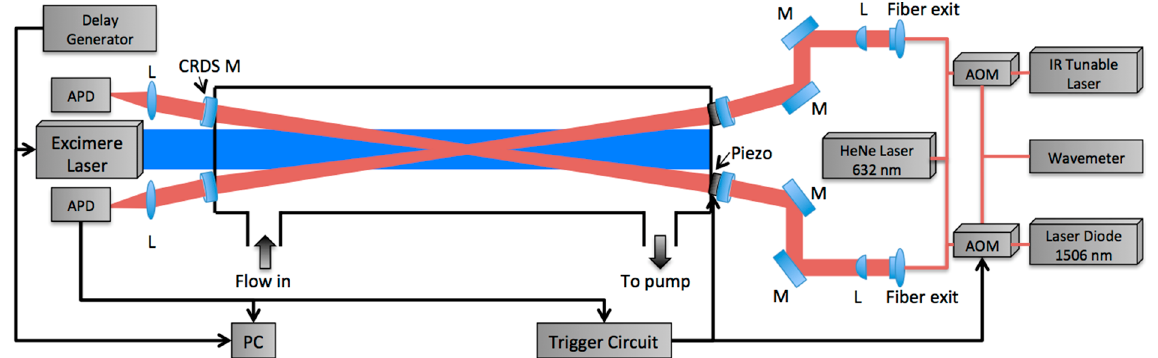
Figure 1. Schematic view of the used experimental setup: AOM, Acousto-Optic Modulator; APD, Avalanche Photo Diode; M, Mirror; L, Lens. Both cw-CRDS systems are equipped with identical trigger circuits and data acquisition systems.